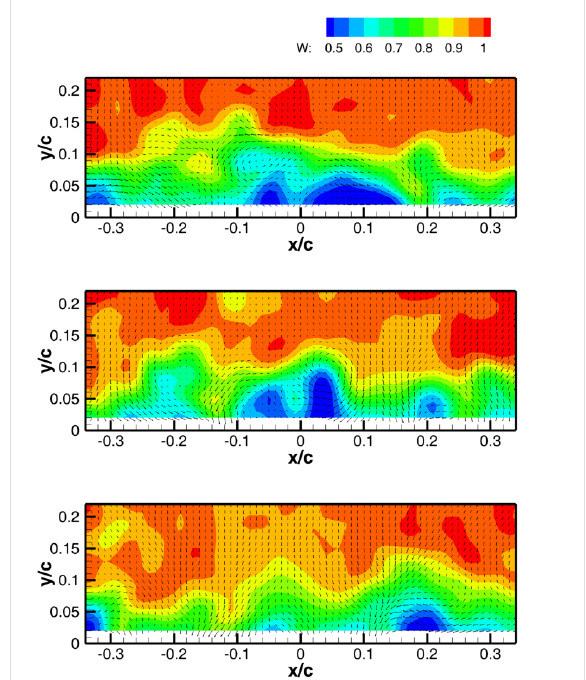
Fig. 5. Instantaneous velocity vectors with vorticity distributions, measuring plane 1 (3 examples) .